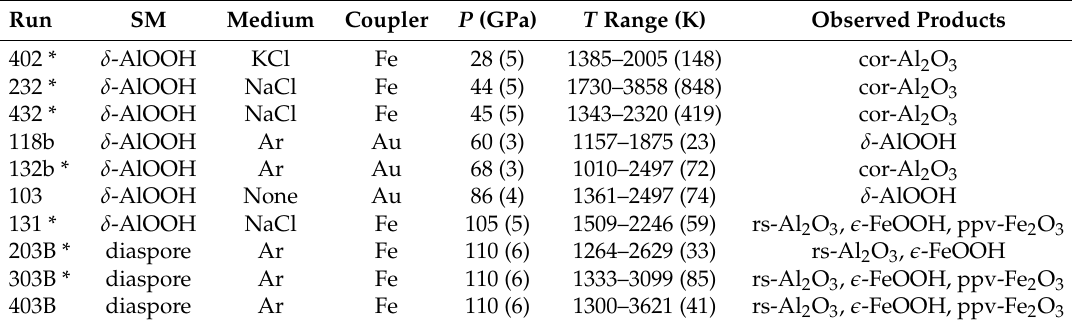
Table 1. Experimental runs conducted in this study. SM: starting material, P : pressure, T : temperature, Medium: pressure transmitting medium, and Coupler: laser coupler for heating. Uncertainties on P and average uncertainties on T ranges are given in parenthesis. Runs in which we observed unknown peaks are denoted by stars